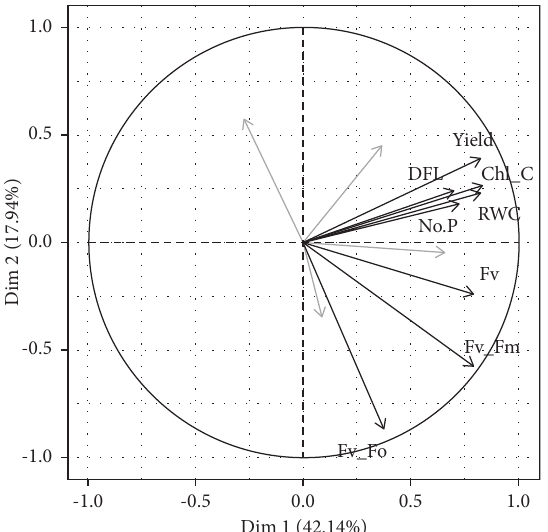
Figure 4: Individual variables under drought stress at the vegetative stage. DFL � days to flowering, RWC � relative water content, Chl_C � chlorophyll content, No.P � number of pods, Fo is the minimal fluorescence after dark adaptation, Fm is the maximal fluorescence, Fv/Fm � (Fm–Fo)/Fm is the maximum quantum yield, and Fv/Fo � (Fm–Fo)/Fo is a more sensitive plant stress detector than